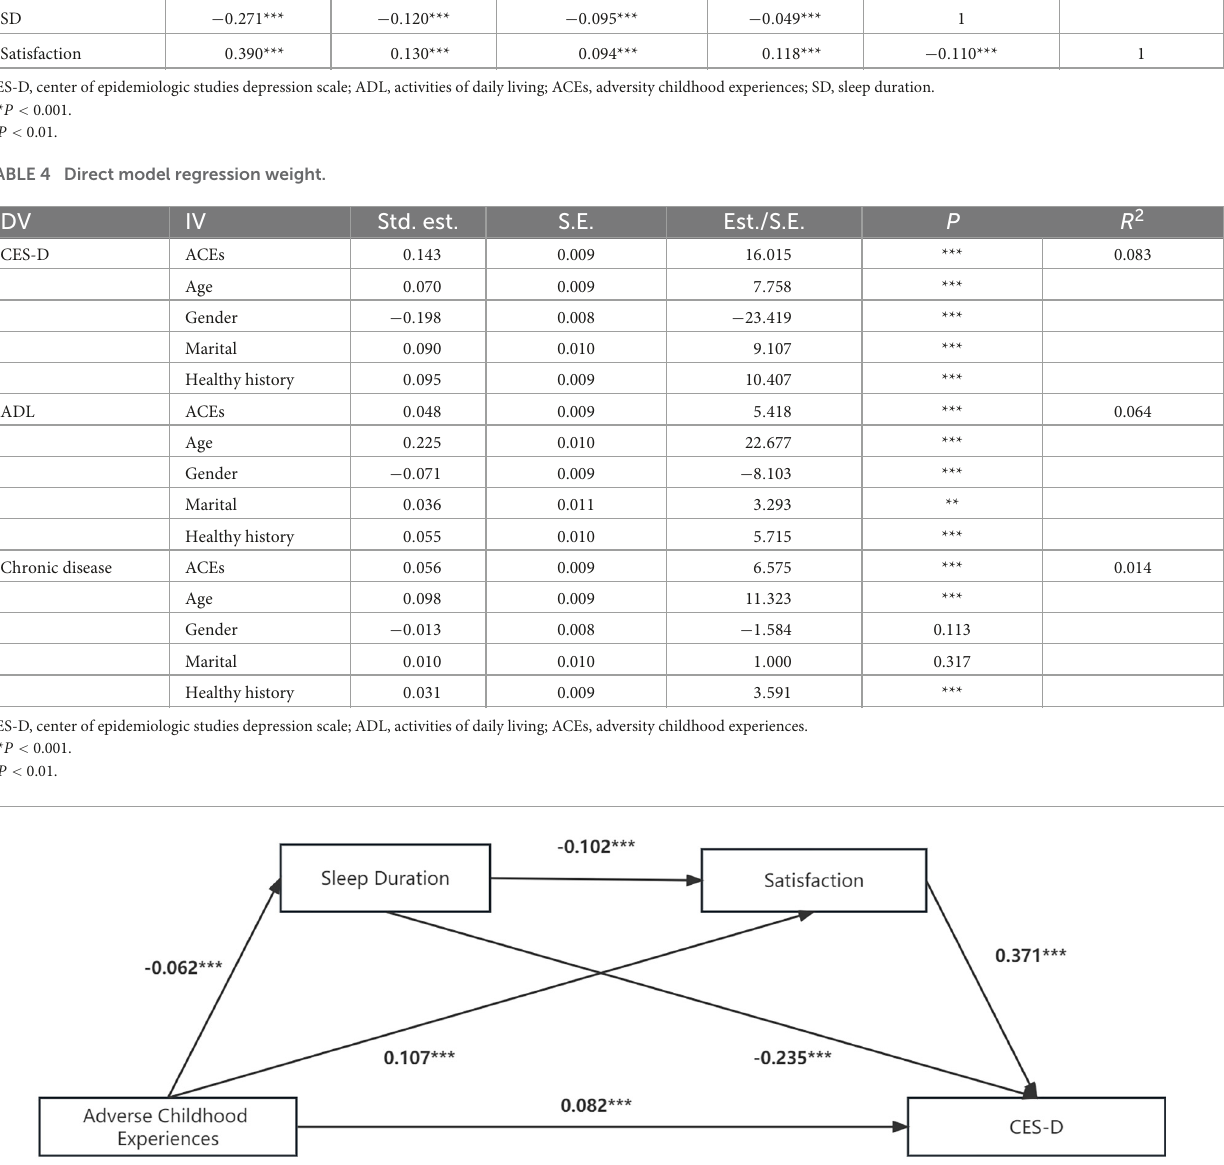
ACEs on depression symptoms through sleep time and life satisfaction was 0.002, accounting for 1.7% of the total effect. The size of the direct effect of ACEs on depression symptoms was 0.082, accounting for 59.1% of the total effect. The CIs corresponding to each mediation path did not include 0, indicating that the multiple mediating effects between ACEs and depressive symptoms were valid (sleep duration and satisfaction were